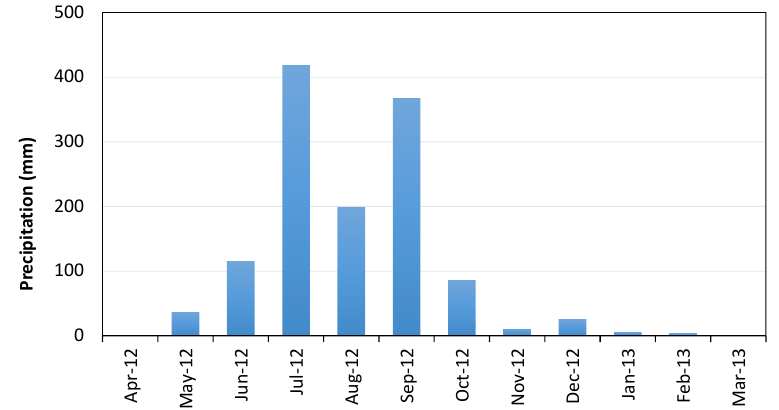
Figure 4. Total monthly precipitation during April 2012 to March 2013.